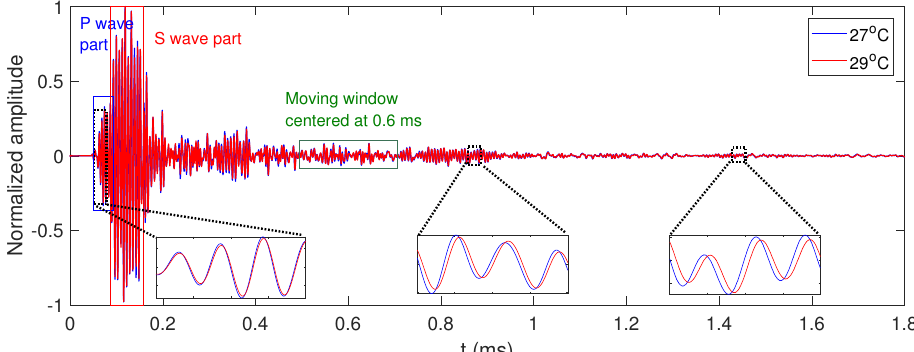
Figure 7. Two ultrasonic signals collected at 27 ◦ C and 29 ◦ C. Three zoomed insets show the time shifts at different window